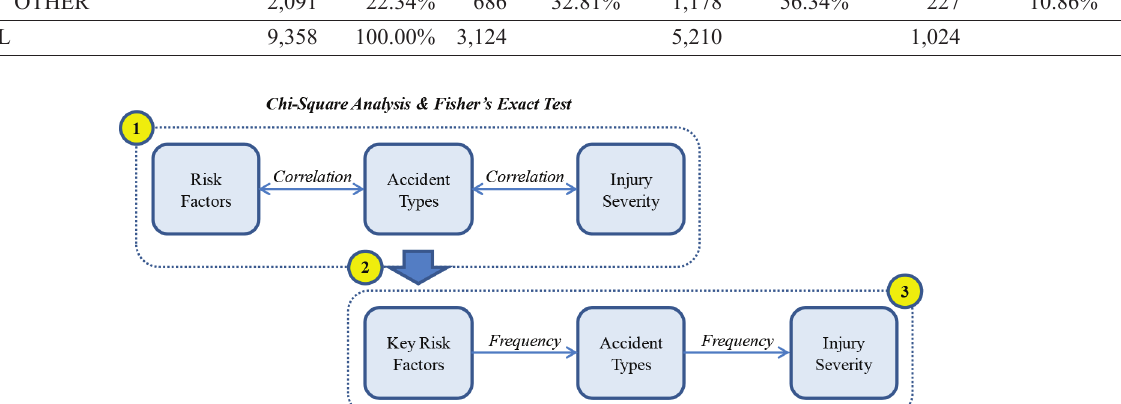
Fig. 1. Conceptual analysis